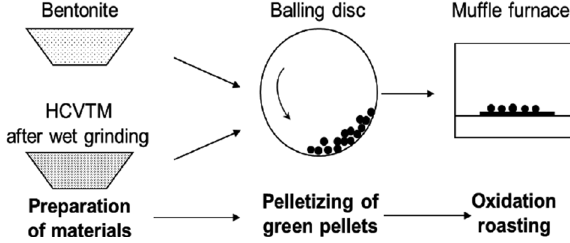
Figure 4: Three procedures of the oxidation test.